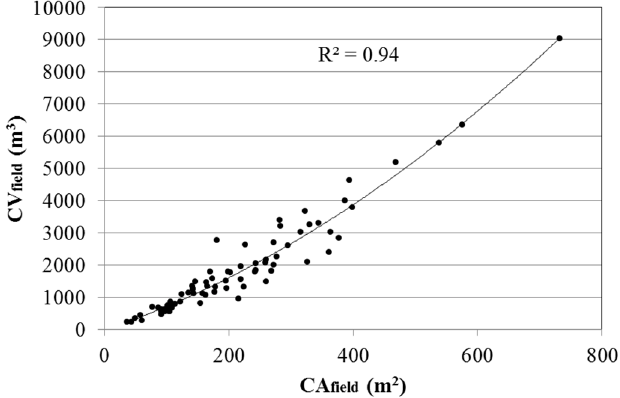
Figure 8. Scatterplot between canopy volume (CV field ), as calculated using Equation (1), and measured crown projected area (CA field ) derived from field measurements. The solid curve is the best-fit, polynomial regression equation.